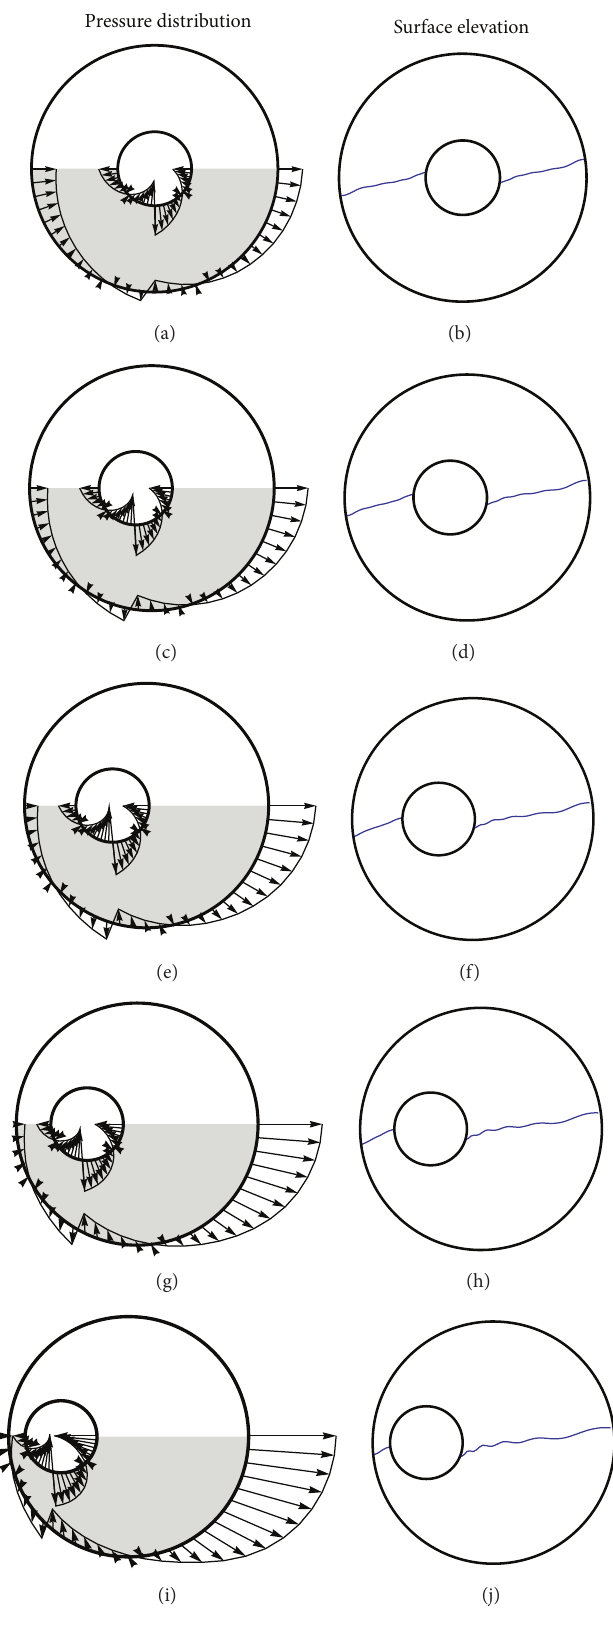
Figure 7: Typical pressure distributions acting on the tank wall and free surface